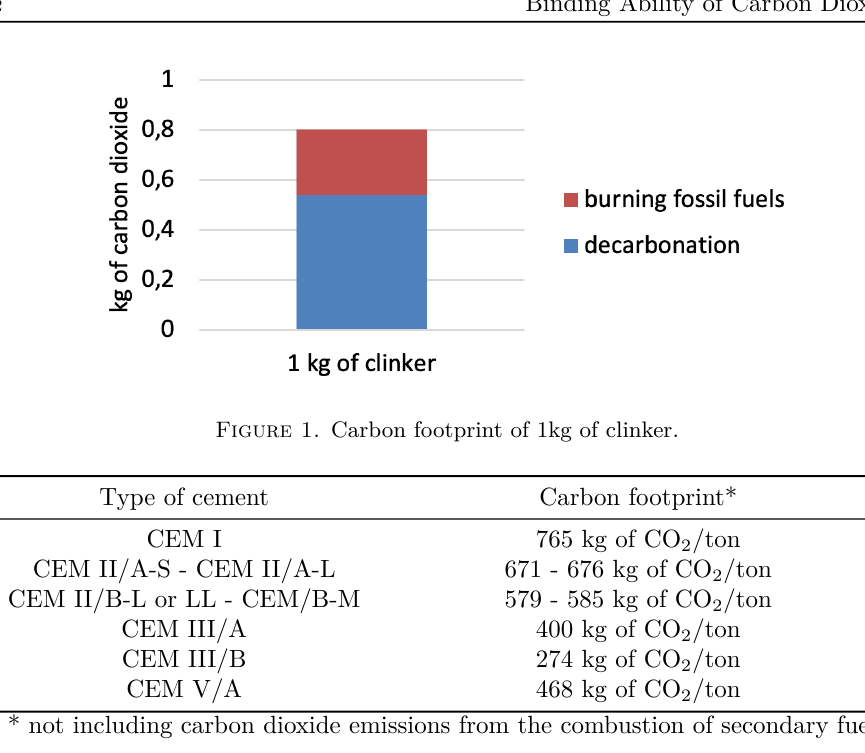
Table 1. Carbon footprint of the di ff erent types of cement in France (in average)